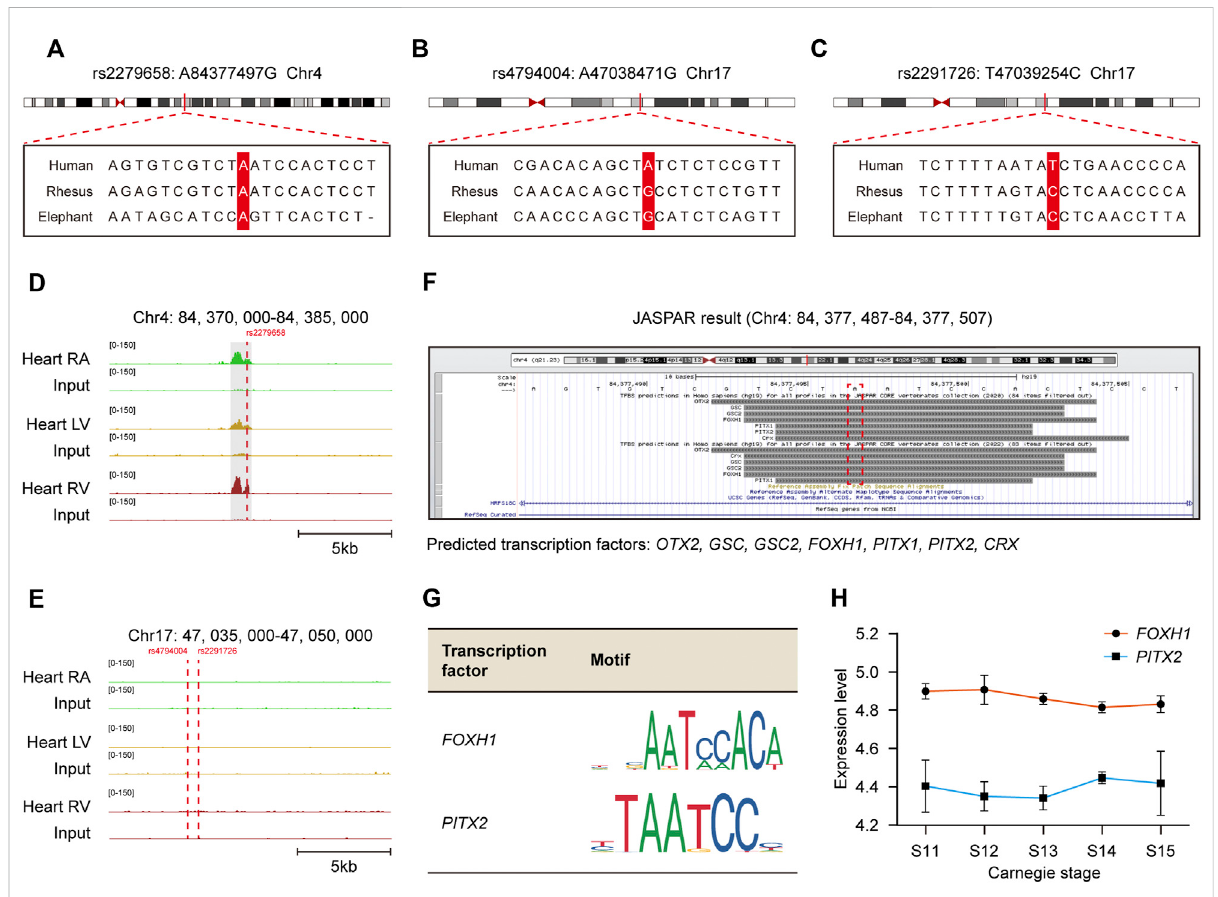
FIGURE 4 Recognization of cis -regulatory SNP rs2279658 related to complex VSD susceptibility and its corresponding TFs. (A – C) Alignment of the human, rhesus and elephant DNA sequences in loci around SNP rs2279658 (A) , rs4794004 (B) and rs2291726 (C) , respectively. The SNP loci are highlighted in red. (D – E) IGV views of genomic loci around SNP rs2279658 (D) , rs4794004 (E) and rs2291726 (E) . H3K27ac peaks activated in hESC, MES, CPC or CM are highlighted in gray. (F) Predicted TFs bound to the rs2279658 locus via JASPAR database. (G) Motifs of FOXH1 and PITX2 . (H) Line plot showing expression levels of FOXH1 and PITX2 across human cardiac